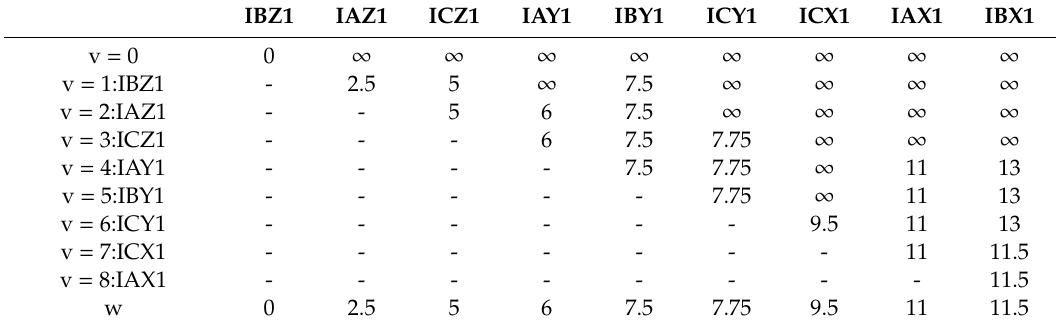
Table 1. Calculating